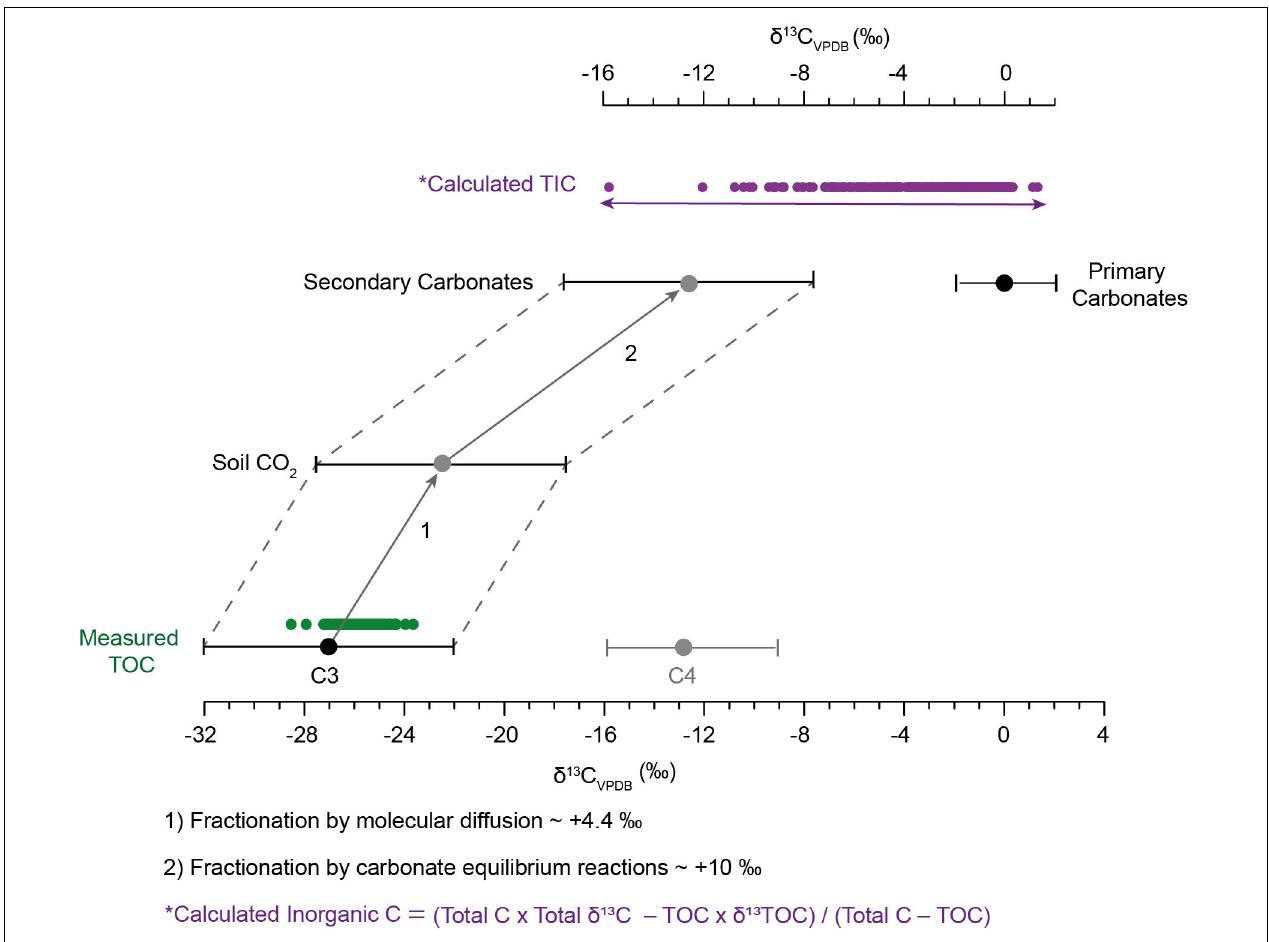
FIGURE 2 | Model of stable C isotope fractionation in calcareous terrestrial systems (redrawn from Nordt et al., 1998). Green dots represent measured δ 13 C ( TOC ) composition of core REM 3A. Purple dots indicate calculated δ 13 of total inorganic C (Total C – TOC). The range of values confirms the presence of primary and secondary carbonates, which can be differentiated and quantified by end-member modelling (Salomons and Mook,